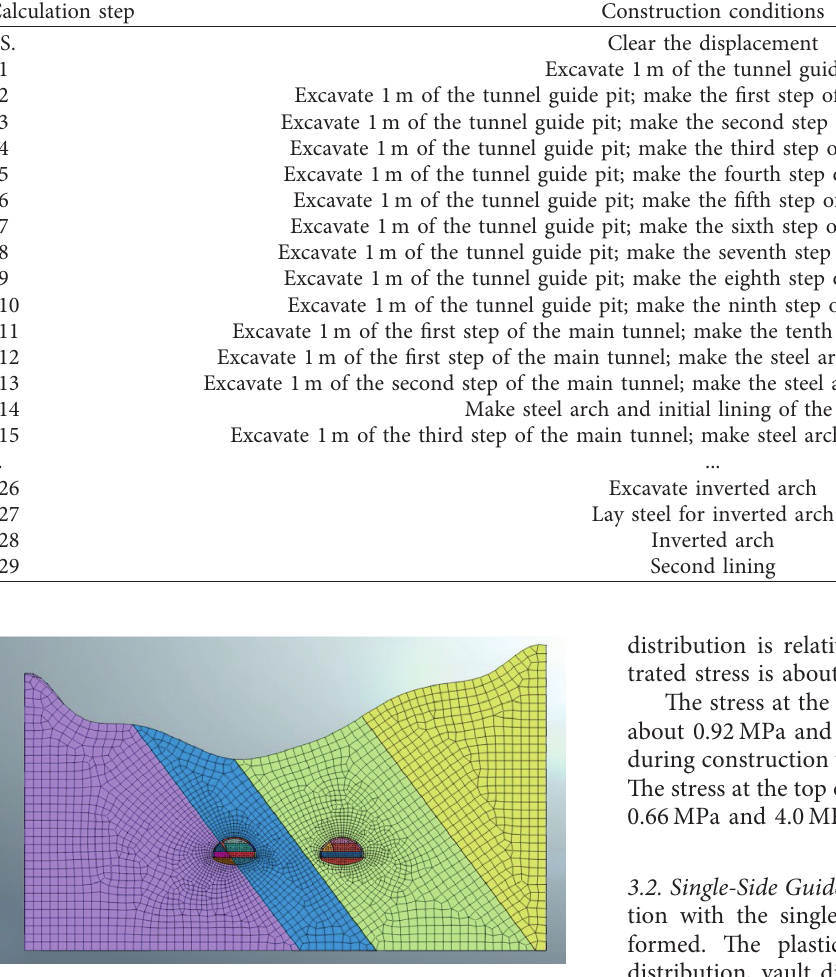
Figure 6: Model of the single-side guide pit method.